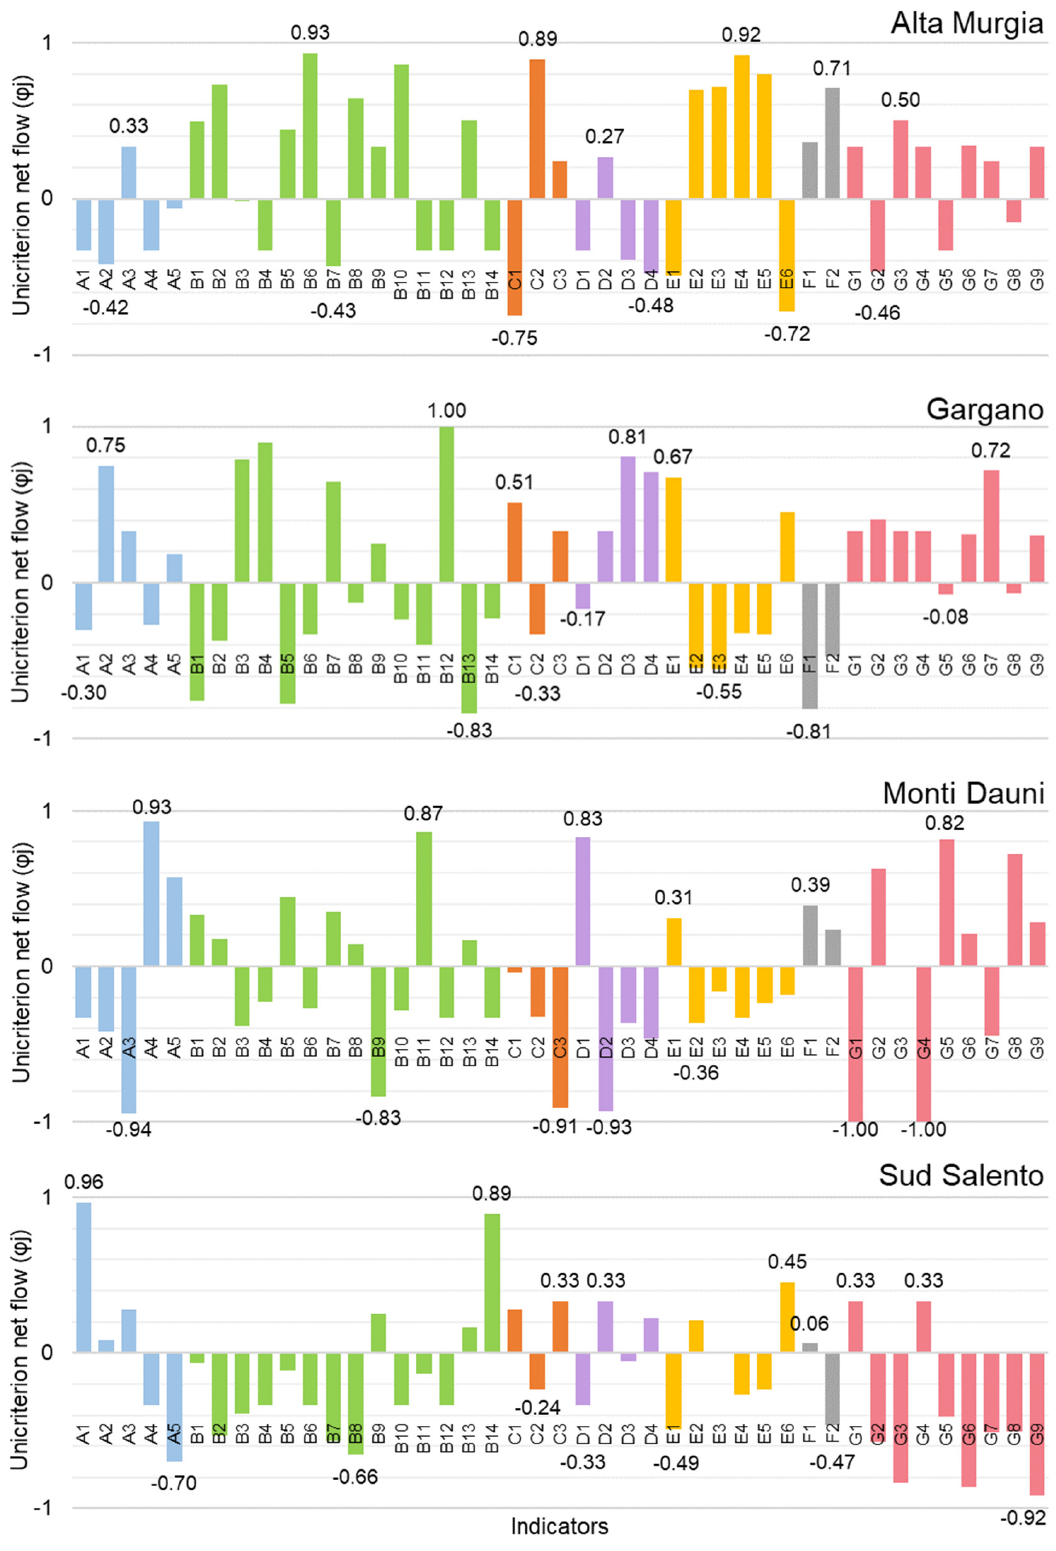
Figure 2. The development profiles (unicriterion net flow, ϕ j ) of the inner areas showing the indica- tors’ performances for each thematic dimension. The best and worst performances are pointed out with the specific values of ϕ j